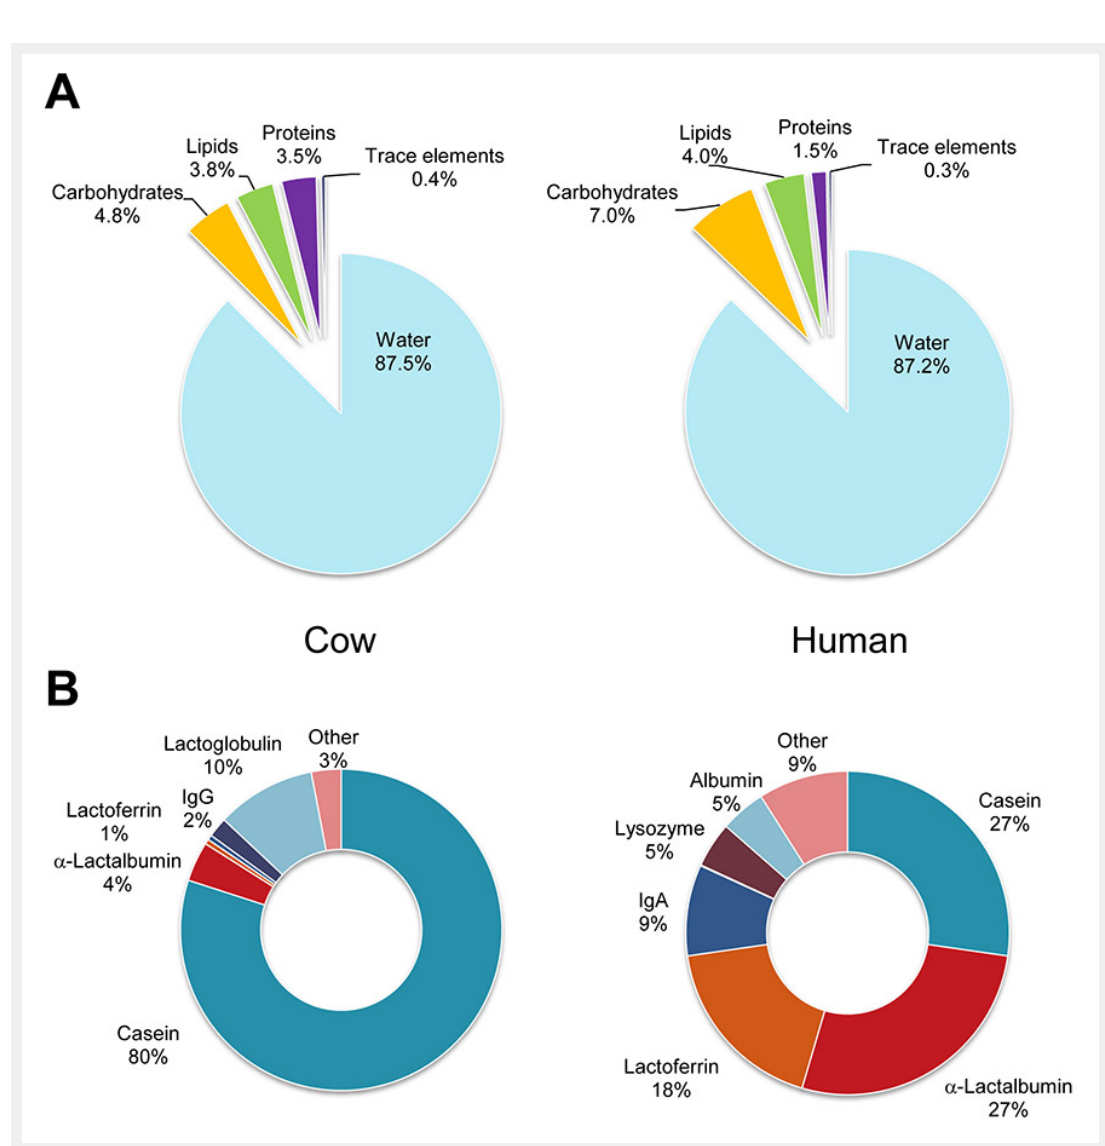
Figure 1 Composition of breast milk and cow’s milk. (A) General molecular classes given in percent of total mass. (B) Percentage of main types of milk